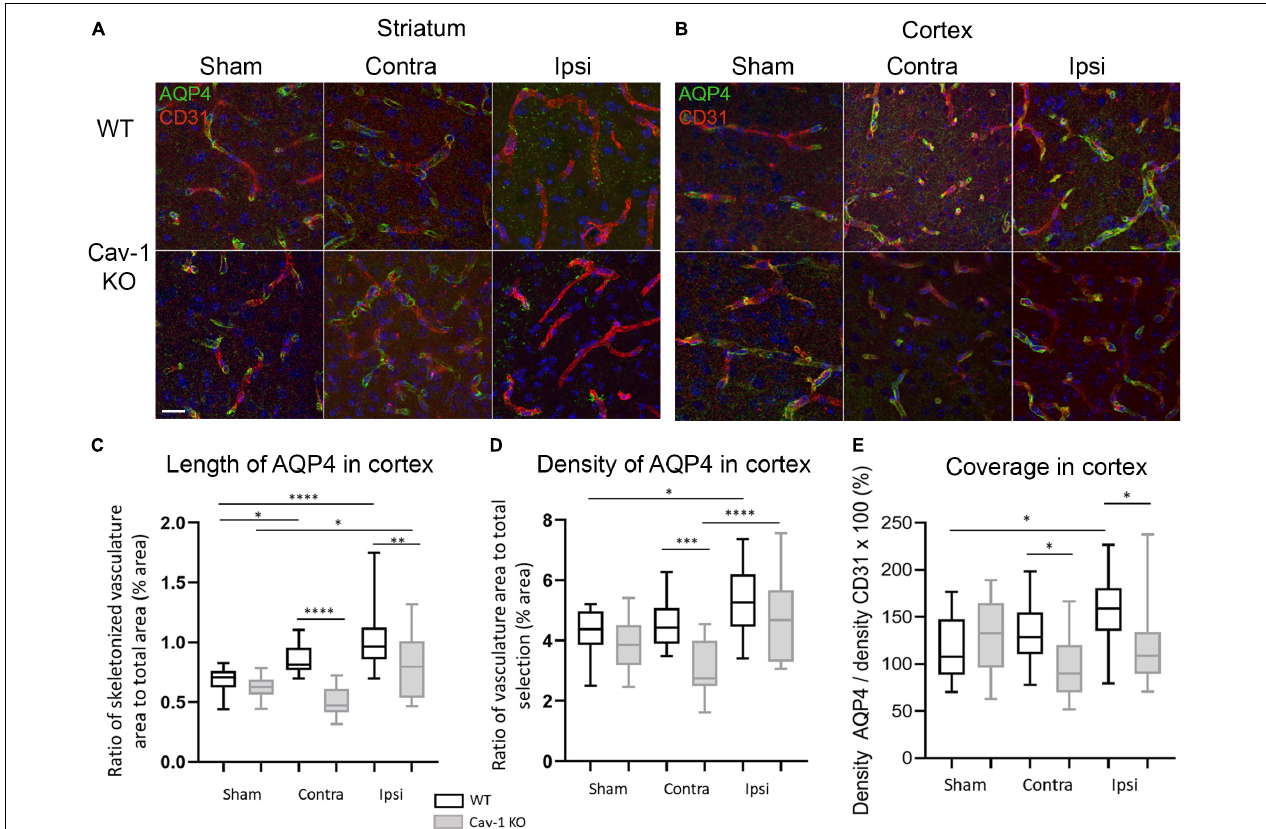
FIGURE 2 | (A) High magnification images of AQP4 on vessels stained by CD31 at 72 h post-MCAO ( × 63 magnification) in the striatum. (B) High magnification images of AQP4 on vessels stained with CD31 at 72 h post-MCAO ( × 63 magnification) in the cortex. (C) Analysis of the length of AQP4-immunolabeled vessel-like structures with Fiji vascular density plug-in in WT and Cav-1 KO after MCAO and in sham animals; n = 3 areas per animal with three animals per group. Black and gray plots refer to WT and Cav-1 KO animals, respectively. Significant differences between WT and Cav-1 KO animals are noted as * p < 0.05, ** p < 0.01, *** p < 0.005 and **** p < 0.001. WT-Sham compared to WT-Ipsi: 95% CI [ − 0.4949 to − 0.1666], p < 0.0001, WT-Sham compared to WT-Contra: 95% CI [ − 0.3330 to − 0.004702], p = 0.04, KO-Sham compared to KO-Ipsi: 95% CI [ − 0.3355 to − 0.007202], p = 0.0354, WT-Contra compared to KO-Contra: 95% CI [0.1888 to 0.5171], p < 0.0001, and WT-Ipsi compared to KO-Ipsi: 95% CI [0.05398 to 0.3822], p = 0.0027. (D) Analysis of the density of AQP4-immunolabeled vessel-like structures assessed by the same Fiji plug-in. WT-Sham compared to WT-Ipsi: 95% CI [ − 1.985 to − 0.09168], p = 0.0229, WT-Contra compared to KO-Contra: 95% CI [0.5432 to 2.436], p = 0.0002, KO-Contra compared to KO-Ipsi: 95% CI [ − 2.594 to − 0.7009], p < 0.0001. (E) Analysis of the coverage of AQP4 on vessels measured as the ratio between the density of AQP-4 vessel-like pattern and CD31-labeled vessels. WT-Sham compared to WT-Ipsi: 95% CI [ − 73.27 to − 1.223], p = 0.0384, WT-Contra compared to KO-Contra: 95% CI [3.157 to 75.20], p = 0.0247, WT-Ipsi compared to KO-Ipsi: 95% CI [3.509 to 75.55], p = 0.0228. Contra: contralateral hemisphere to the lesion, Ipsi: ipsilateral hemisphere to the lesion. Scale bar = 20 µ m. Comparisons were carried out by one-way ANOVA with Tukey’s multiple comparisons